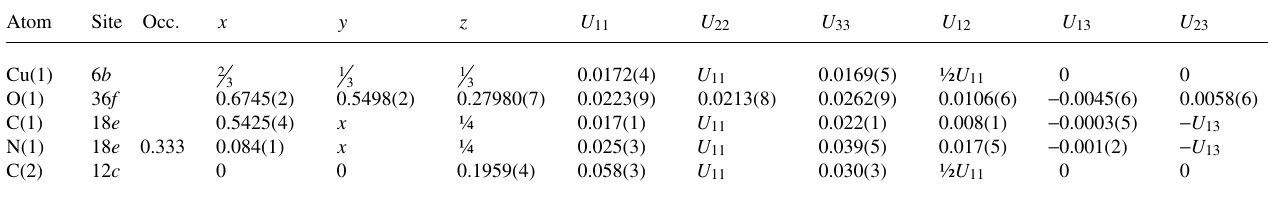
Table 3. Atomic coordinates and displacement parameters (in Å 2 ) .